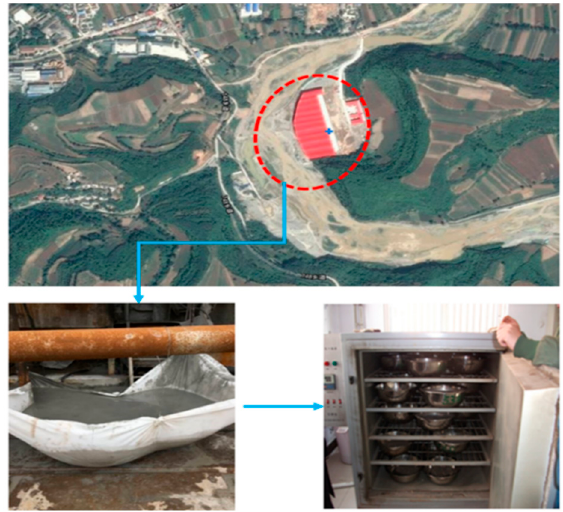
Figure 1. Sampling location and sampling process.